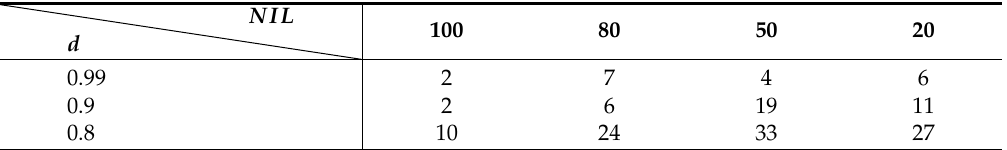
Table 2. Epochs took for convergence to the correct solution with a data sampled rate 5 Hz, where d , decreasing coefficient of the standard jump amplitude; NIP , number of inner loops for the search procedure with one standard jump